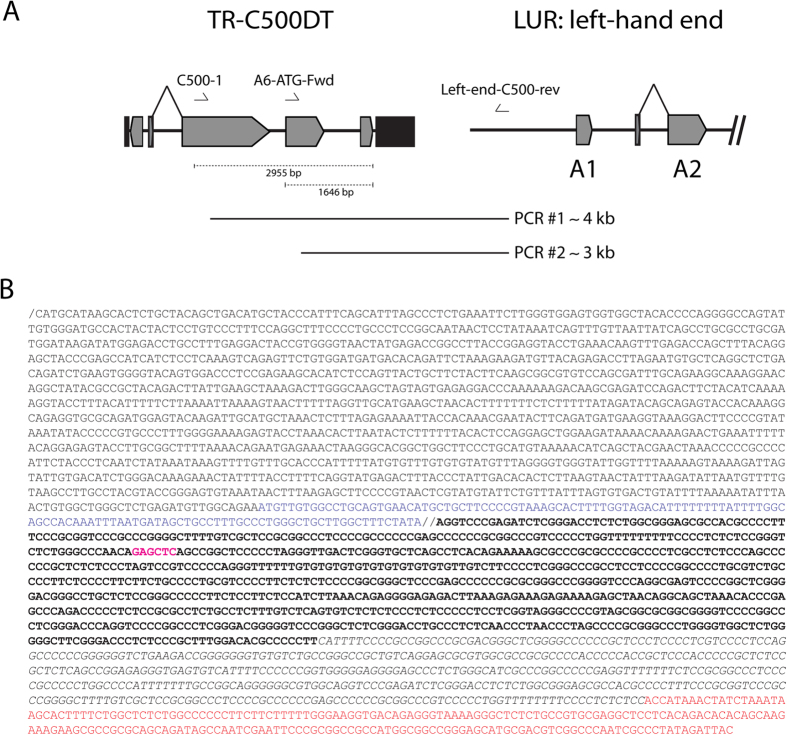
Precise localization of the duplicated region in the BAC clone by PCR and Sanger sequencing.(A) Locations of primers used. (B) Sanger sequence of the relevant parts of PCR #2. The left end of LUR is shown in red, and double-lined breaks indicate the junction between C500DT and TR. The truncated A7 sequence in TR-C500DT is shown in blue. The sequence in bold indicates the last 800 bp of TR. The italicized sequence indicates the first 452 bp of TR. Purple sequence indicates SacI restriction site.